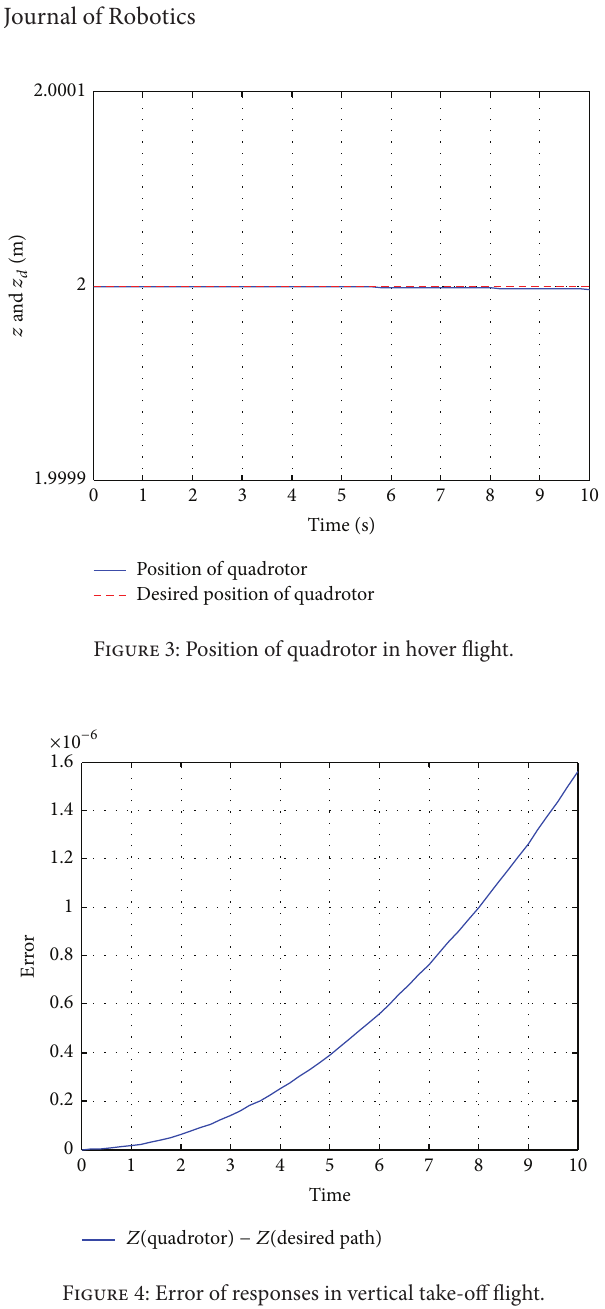
Figure 4: Error of responses in vertical take-off flight.